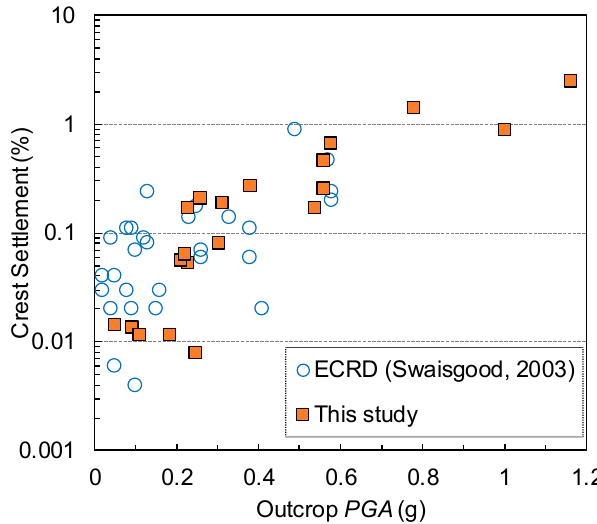
Figure 6. Comparison of crest settlement versus outcrop PGA data of ECRD presented in Swaisgood [1] and this study.